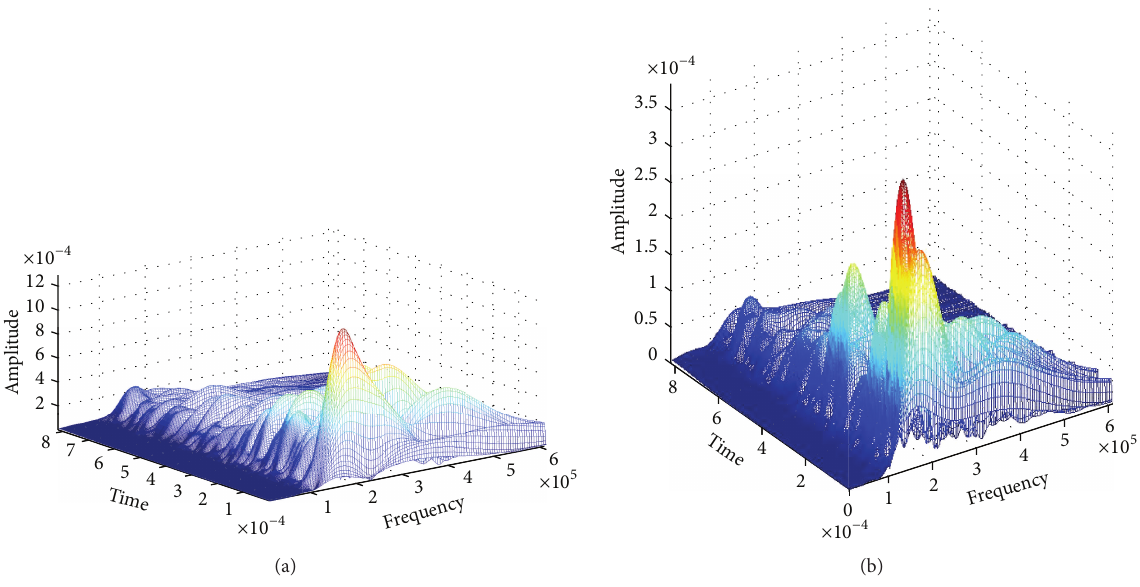
Figure 8: Fracture (a) base metal and (b) welded